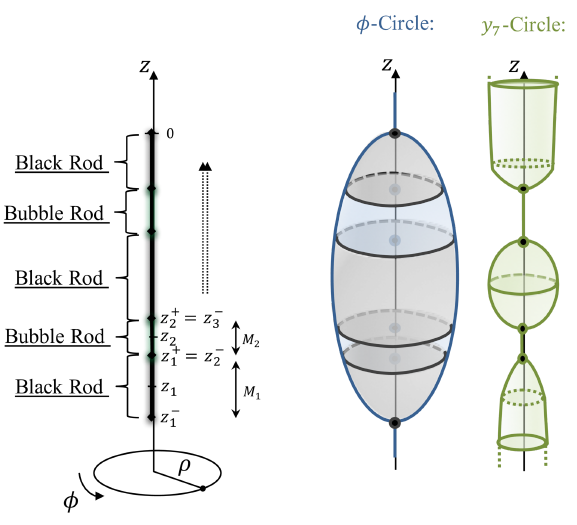
Figure 6 . Description of a chain of static four-charge non-extremal black holes and KKm bubbles in the five-dimensional framework (4.11) and the behavior of the φ and y